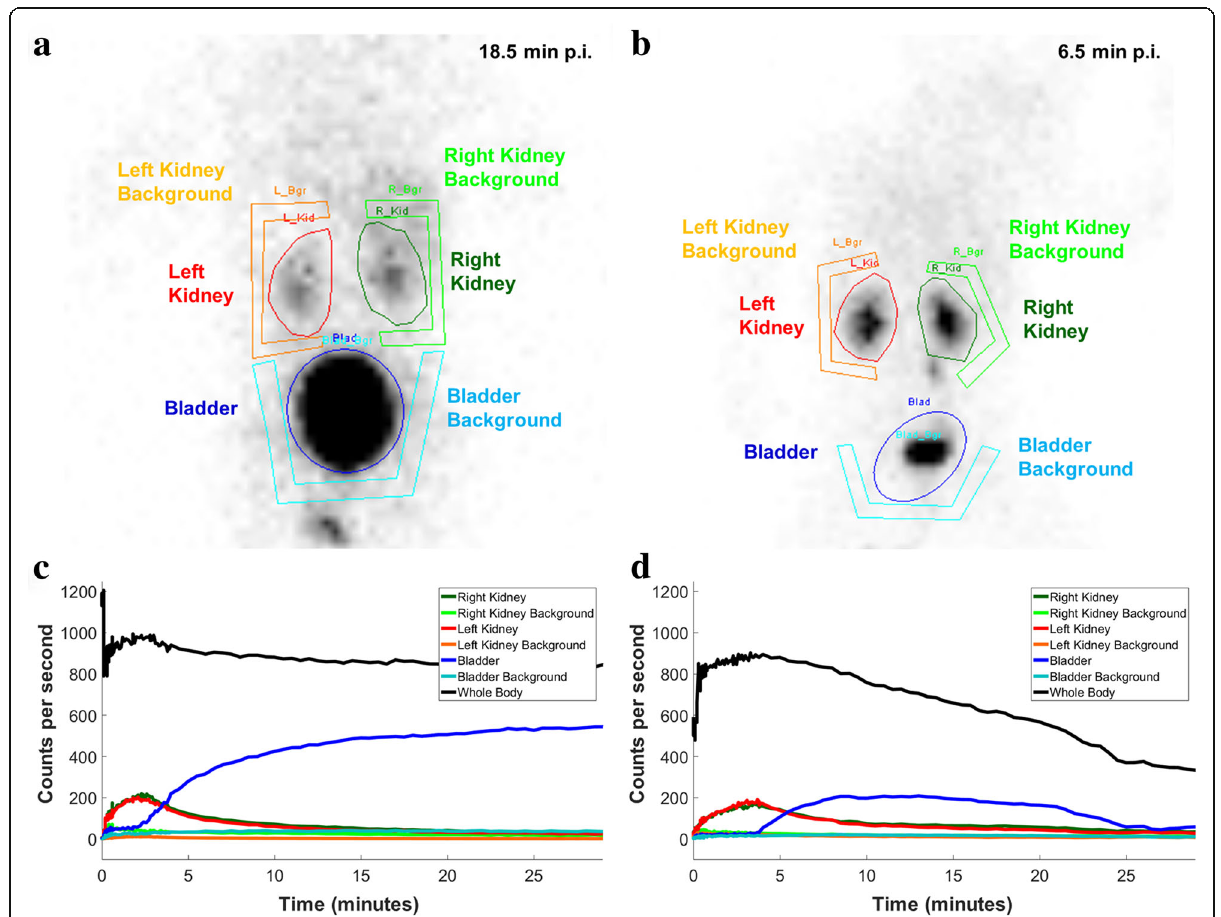
Fig. 3 ROI analysis of patients P20 (left, 20-month-old female) and P10 (right, 5-month-old female). a , b ROIs and background in kidneys ( red : left kidney; green : right kidney) and bladder ( blue ) for multiple time points. The whole-body ROI covers the entire field-of-view and is not depicted. c , d Number of counts as a function of time for all ROIs